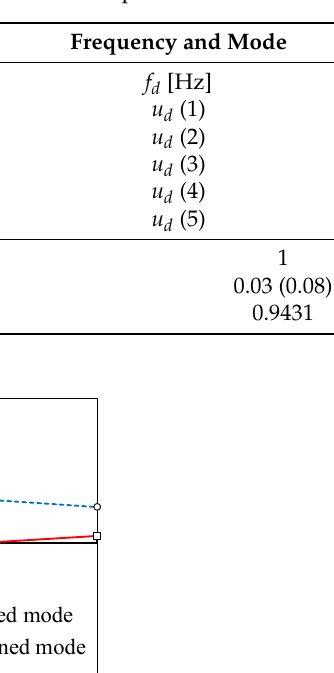
Figure 10. Original FRFs and FRFs after the addition of masses. Table 6. Comparison of natural frequencies and mode shapes.